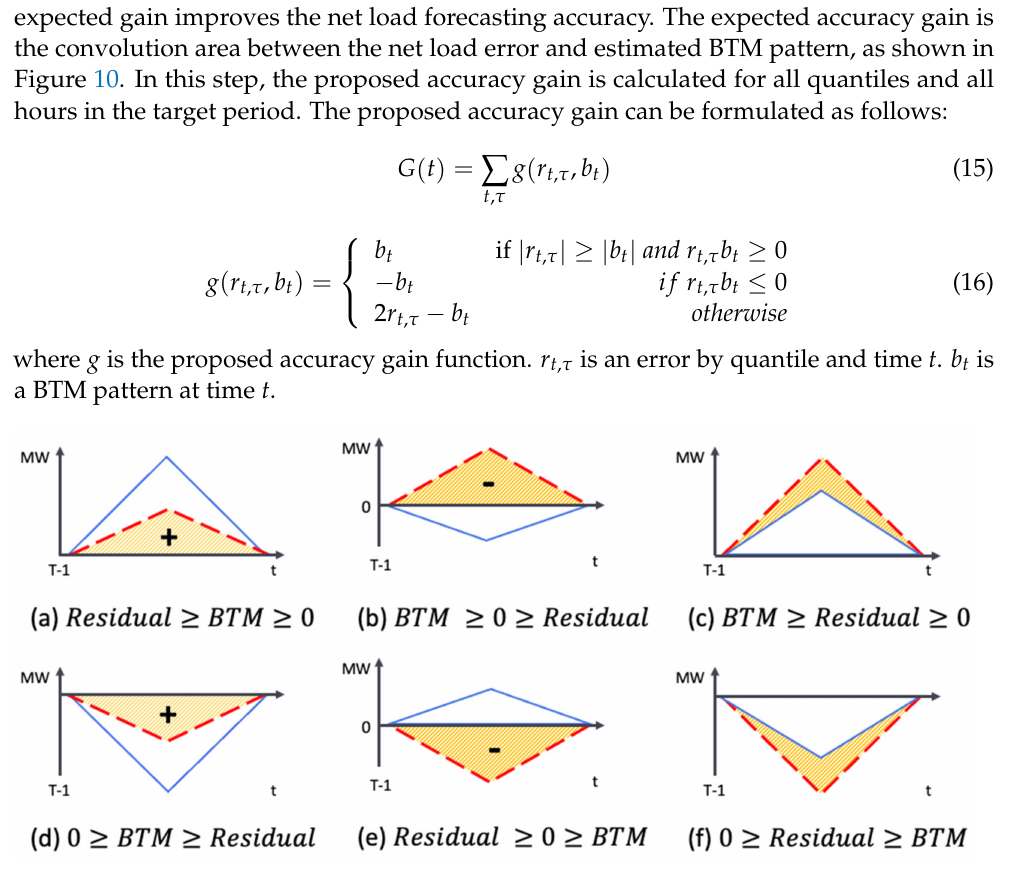
Figure 10. The simplified concept of accuracy gain. The blue line is the error between the actual net load and forecasted load. The red dash line is the estimated BTM pattern. The yellow striped area is an expected change on forecasting result. ( a , d ) show that adding a BTM pattern to net load forecasting can improve performance. ( b , e ) show the situation in which reflecting the BTM pattern increases the forecasting error, so it is marked as negative. ( c , f ) show that a BTM pattern exceeds the